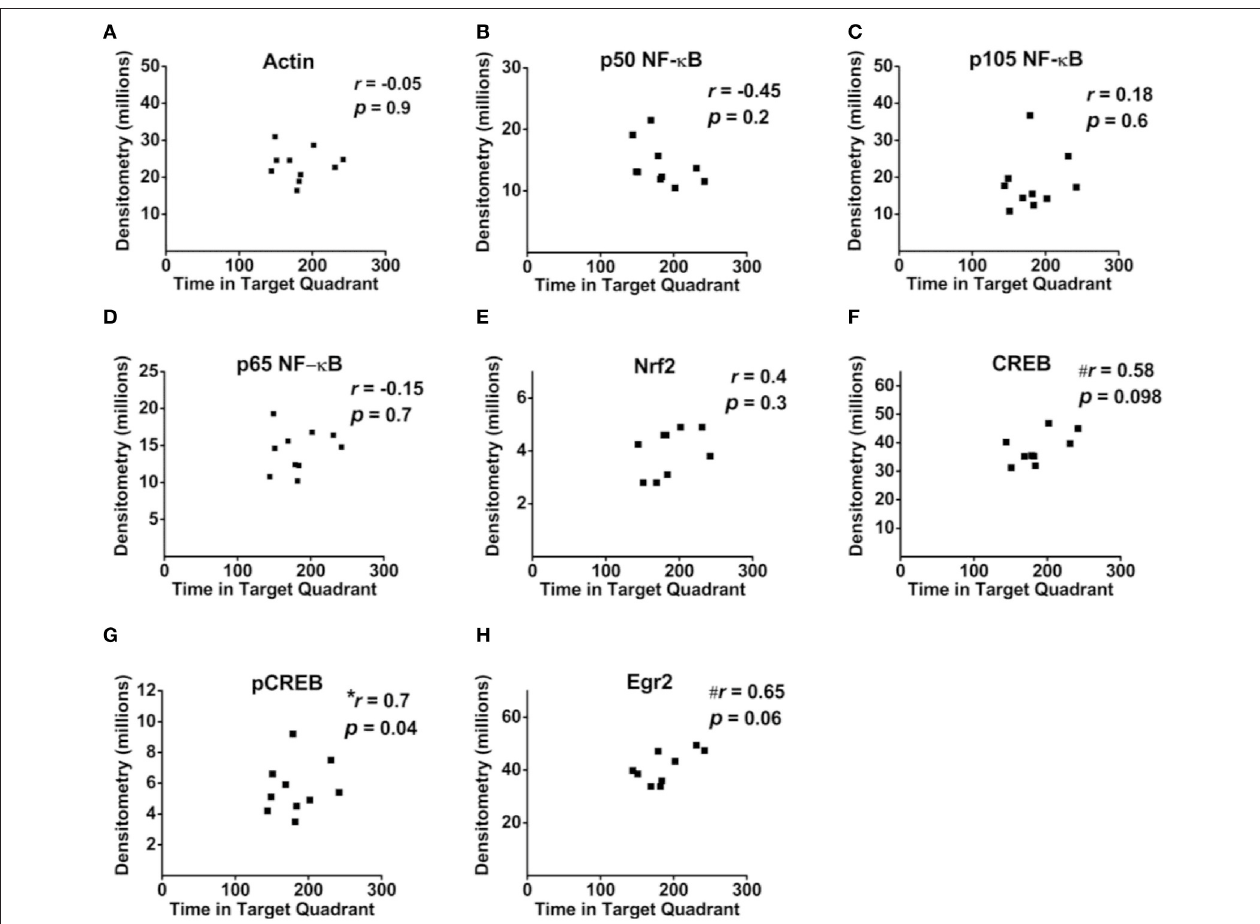
FIGURE 7 | Associations between hippocampal transcription factor protein levels and MWM-retention phase parameter time in target quadrant. (A–H) Scatterplots and Pearson correlation coefficients between densitometry values (normalized to total protein) from Western blot experiments and the time spent in the target quadrant during the MWM retention phase. n = 9